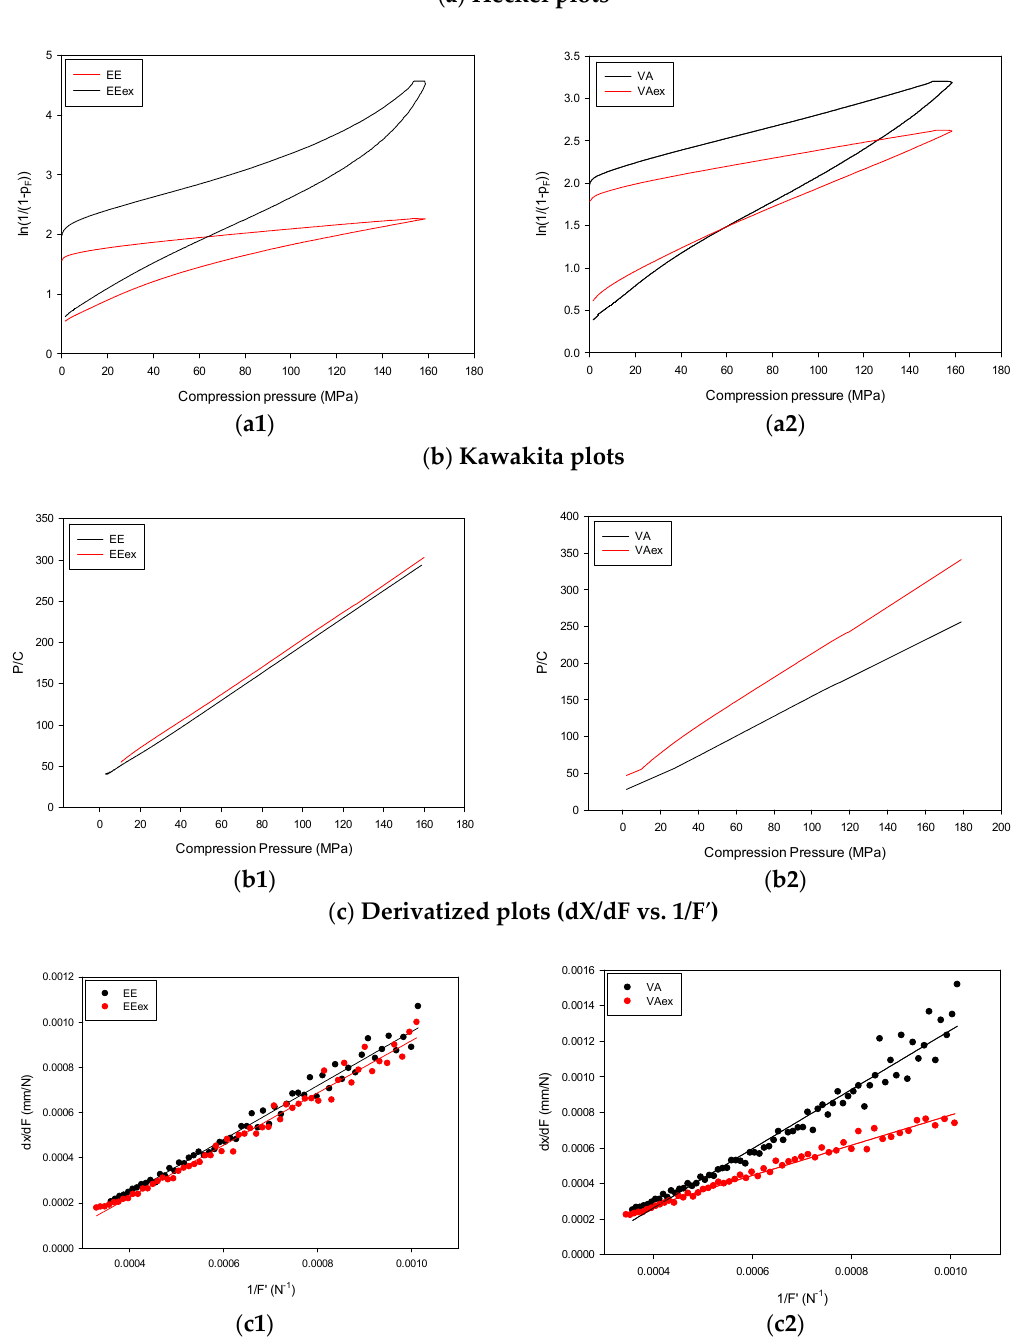
Figure 5. Plots of Heckel ( a ), Kawakita ( b ), and derivatized compression curve ( c ) for neat/extruded Eudragit EPO ( a1 , b1 , c1 ) and Kollicoat VA 64 ( a2 , b2 , c2 ) powders (neat in black, extruded in red